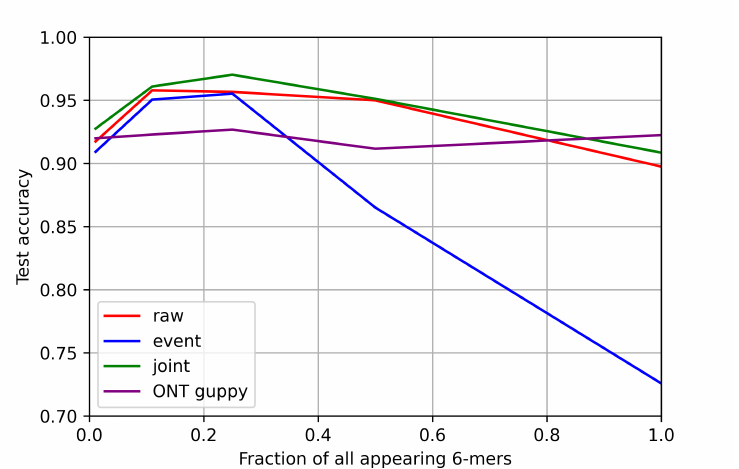
Figure 7. Test read accuracy of models trained on simulated